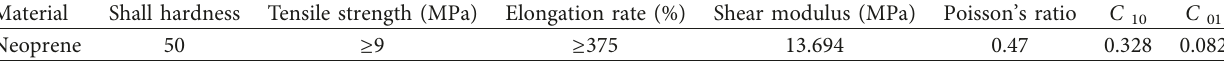
Table 1: Main mechanical parameters of the rubber ring.